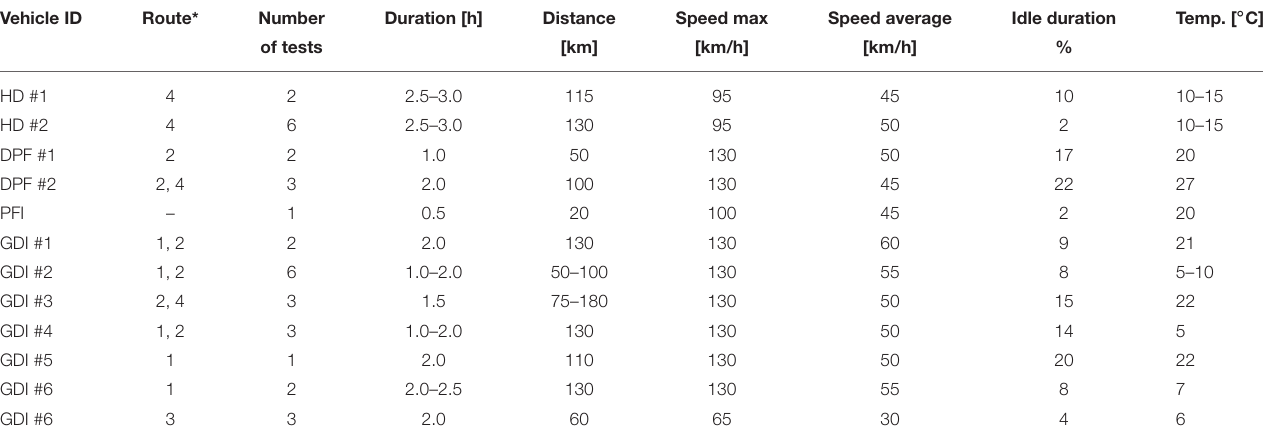
TABLE 3 | Characteristics of on-road test routes. Vehicle